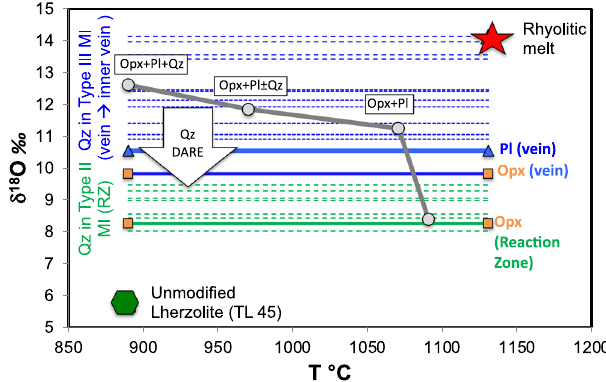
Fig.5|Variationof δ 18 Owithtemperatureduringtheinteractionsbetweenthe rhyolitic melts and the peridotite mantle. Grey circles and lines represent the theoretical variation of δ 18 O values recalculated by mass balance from the MELTS model(SupplementaryTable3).Horizontallinesrepresentthe δ 18 Ovaluesmeasured inthequartzcrystals(thisstudy)andmineralseparates 21 ofthedifferentportionsof the composite xenolith (orange = reaction zone; blue = vein). The mineralogy pre- dictedbytheMELTSmodelarealsoreported.Abbreviations:Opxorthopyroxene;Pl plagioclase; Qz quartz; RZ reaction zone; MI melt inclusions. The vertical arrow represents the effect on δ 18 O of diffusion assisted re-equilibration of quartz crystals with surrounding Opx in the reaction zone (within type II Melt